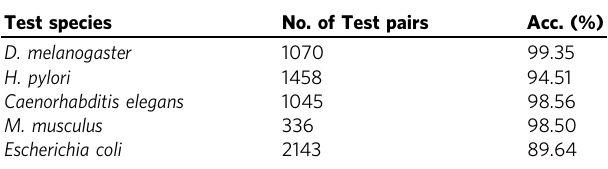
Table 7 Prediction results for independent